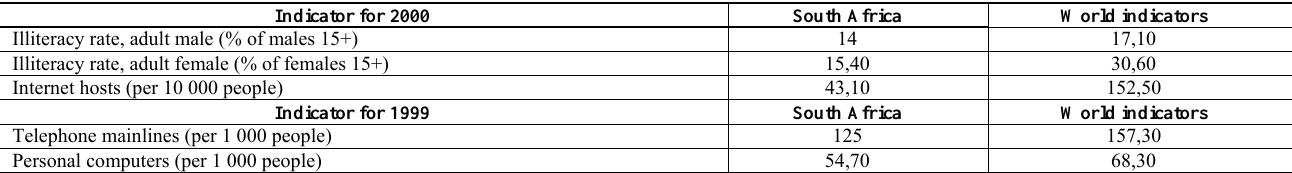
Table 9: Comparison between South Africa and the